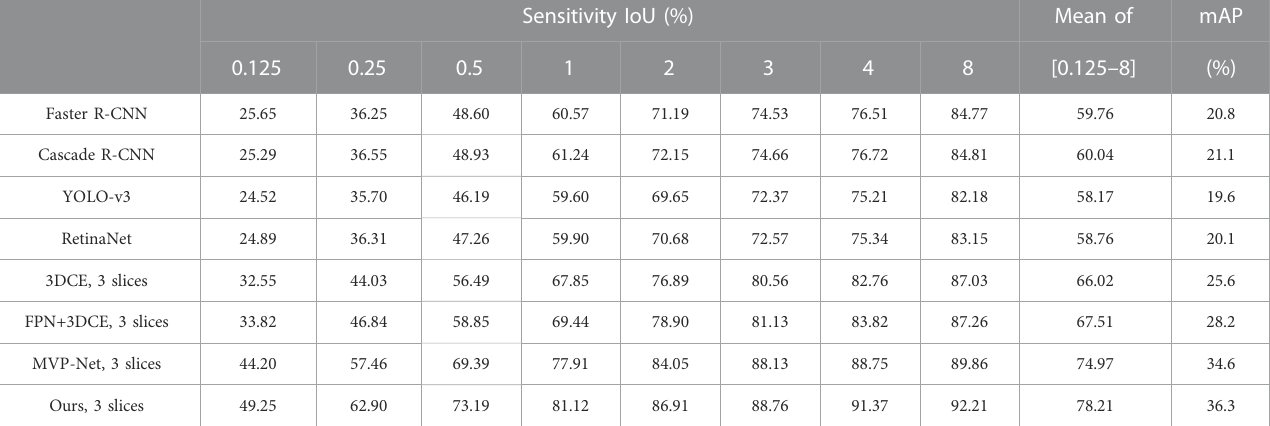
TABLE 2 Comparison with state-of-the-art object detection on DeepLesion. Sensitivity at various FPs per image and mAP on the test set of the of fi cial data split of DeepLesion. IoU criteria and 3 slices input (one key slice and two neighbor slices) are